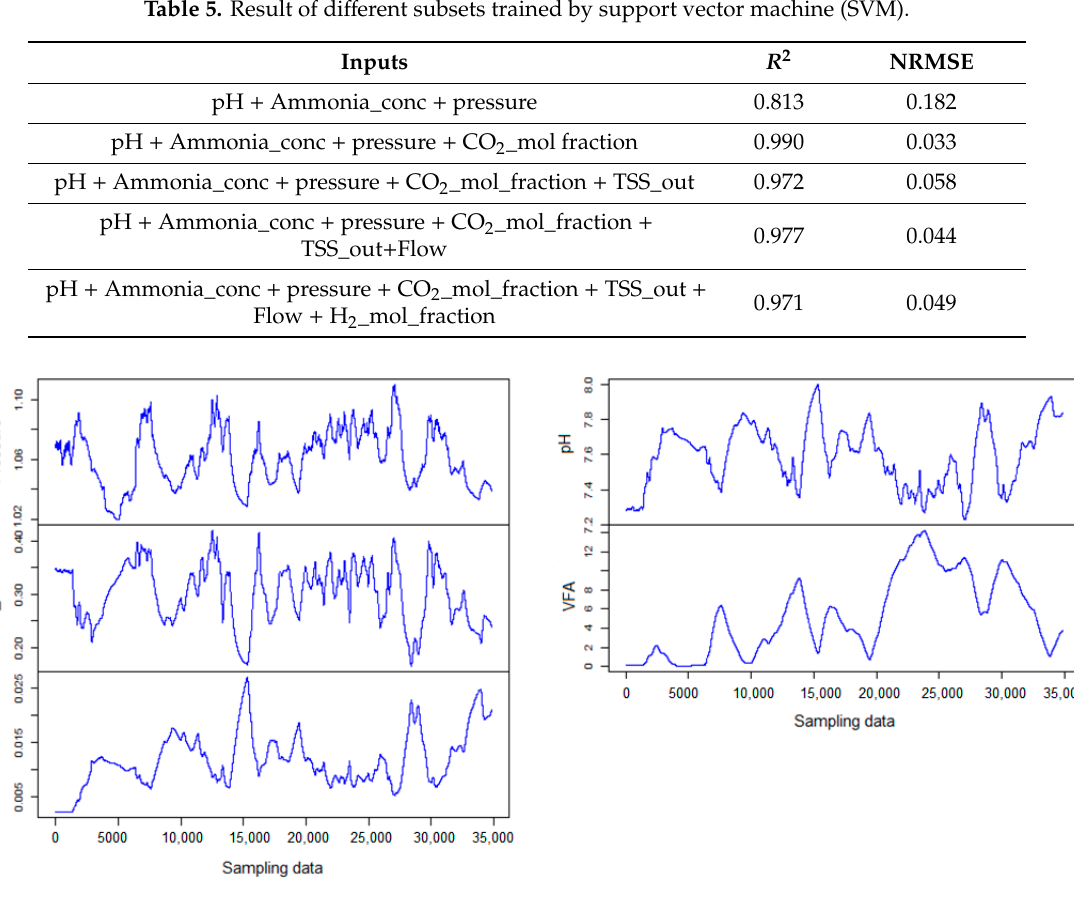
Figure 5. Trend of input and output variables used for developing soft sensors.